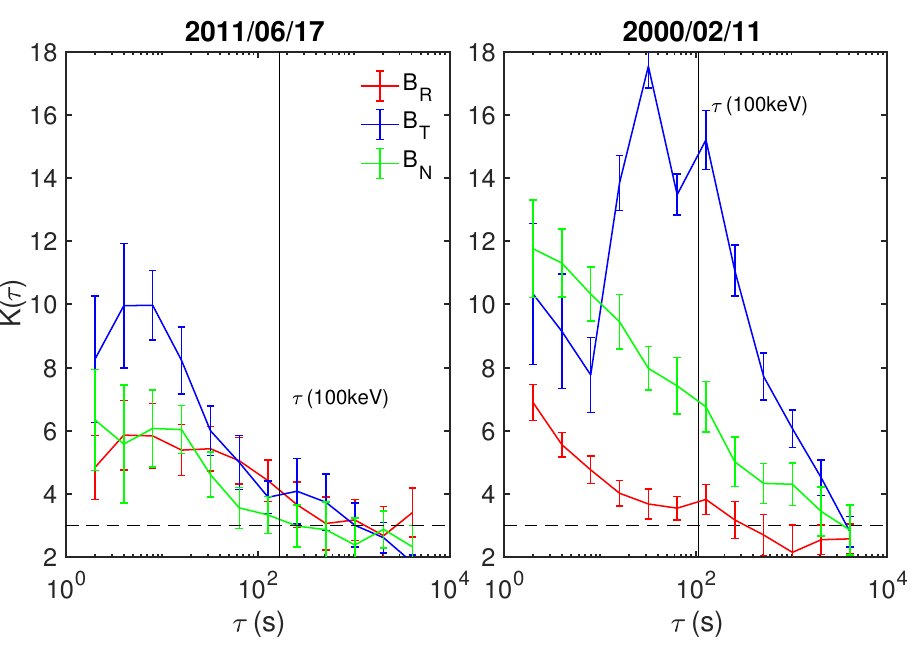
Figure 3. Kurtosis as a function of the time scale τ in the quasi-parallel shock crossing of the 17 June 2011 ( left panel ) and in the quasi-perpendicular shock crossing on 11 February 2011 ( right panel ). The Gaussian level of 3 is indicated by the horizontal dashed line and the time scale corresponding to the Larmor radius of energetic protons of 100 keV is shown by the vertical solid line. Error bars are also